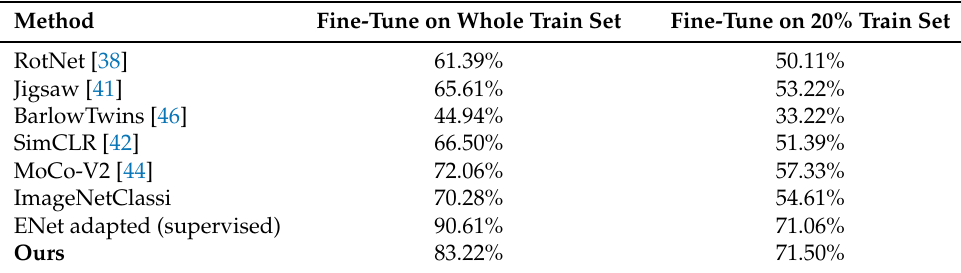
Table 5. Test accuracy of different methods under the fine-tuning evaluation protocol for the 5-class classification problem (the 5 classes being NI, CG of Artlantis, CG of Autodesk, CG of Corona, and CG of VRay). The presented results are classification accuracies on the testing set of a dataset properly constructed from the datasets of Artlantis, Autodesk, Corona and VRay ( cf. the main text for